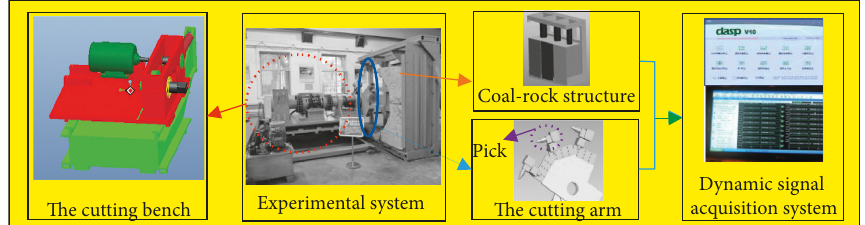
Figure 4: A schematic of machinery dynamic system.